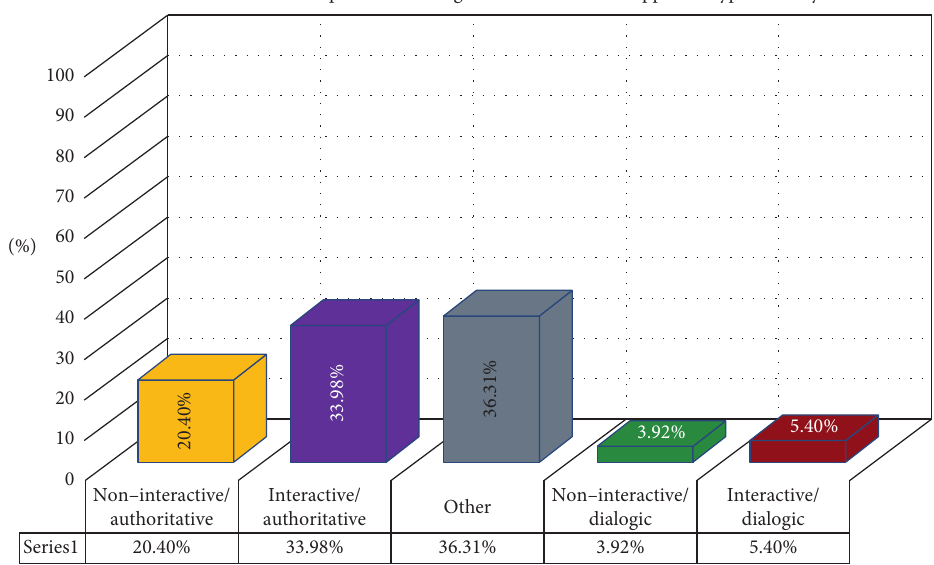
Figure 6: 2 nd action plan—percentages of communicative approach types used by